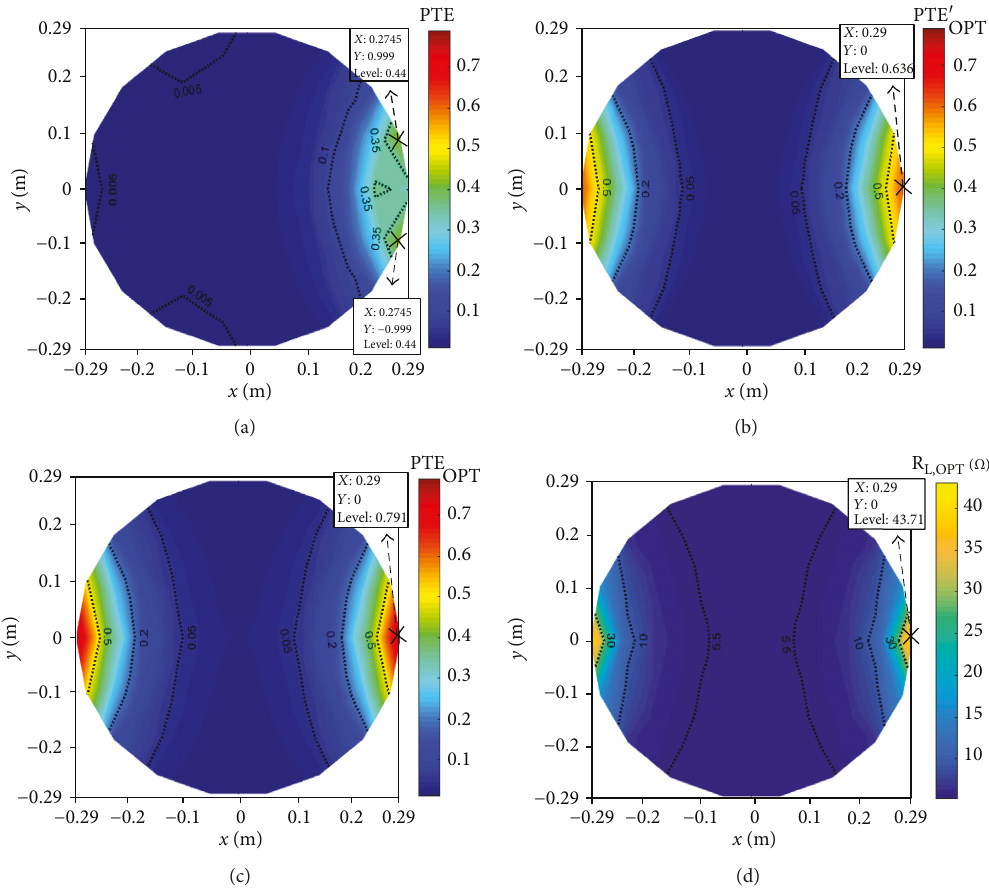
Figure 4: Calculated values of a two-TX system when RX is moving in the study area. E ffi ciency distribution in the study area (a) without optimization, (b) under conditions of V 1 V 2 = M 1 R M 2 R and R L = 10 Ω , and (c) under conditions of V 1 V 2 = M 1 R M 2 R and = R PTE R L L ,OPT . (d) Optimal load for OPT